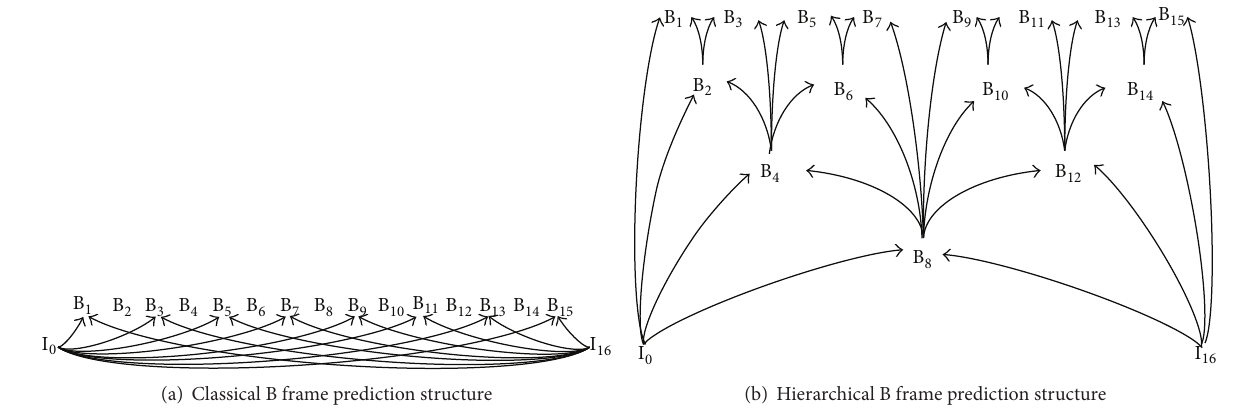
Figure 2: Illustration of classical B frame prediction structure used in MPEG-2 and MPEG-4 Part 2 (without reference arrows for even frames to avoid clutter) and dyadic hierarchical B frame prediction structure of H.264/AVC, H.264 SVC, and